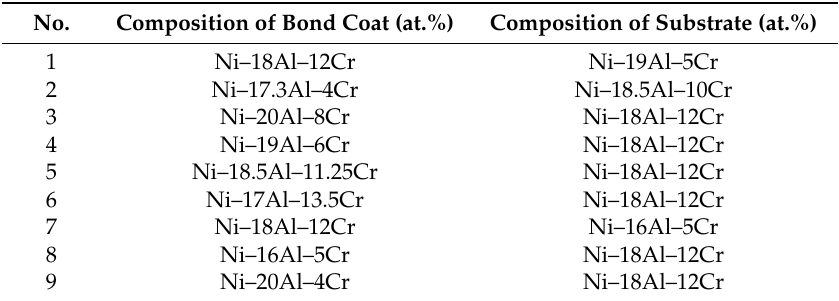
Table 1. List of the constituents of γ + γ '/ γ + γ ' bond coat/substrate systems at annealing temperature 1373 K, with temperature gradient 5000 K/cm in the present phase-field simulations. No. Composition of Bond Coat